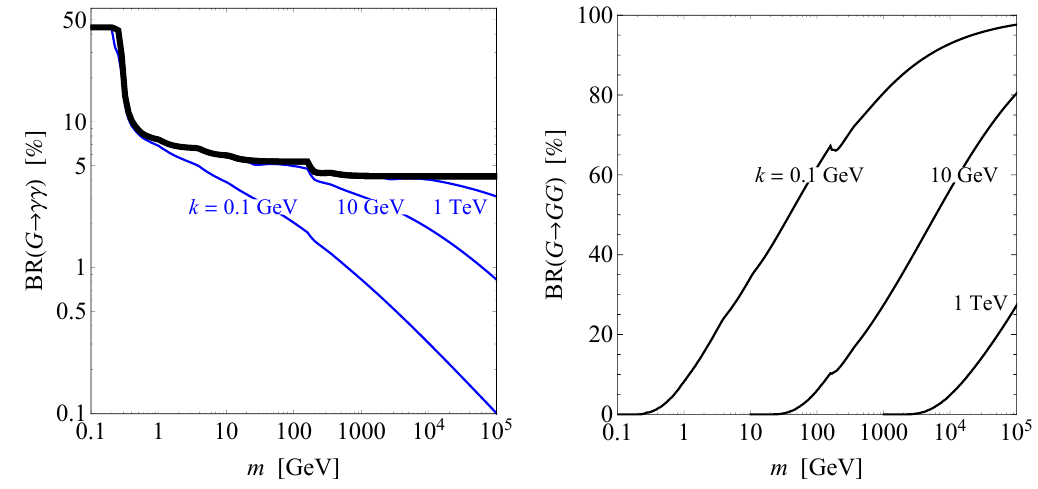
Figure 5 . KK graviton branching fractions to photons (left) and to lighter KK gravitons (right) for k = 0 : 1, 10 and 1000 GeV, as a function of the KK graviton mass. In the left plot, the thick black curve shows the result that would be obtained without accounting for decays to lighter KK modes.